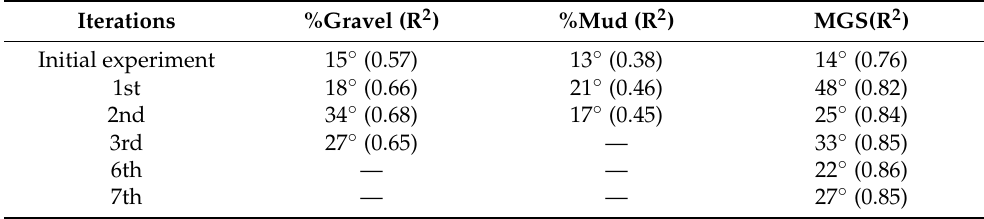
Table 3. Selected feature variables for predicting the sediment grain size properties and the proportion of variance explained by the model (R 2 ) as when only BS was set as explanatory variable.